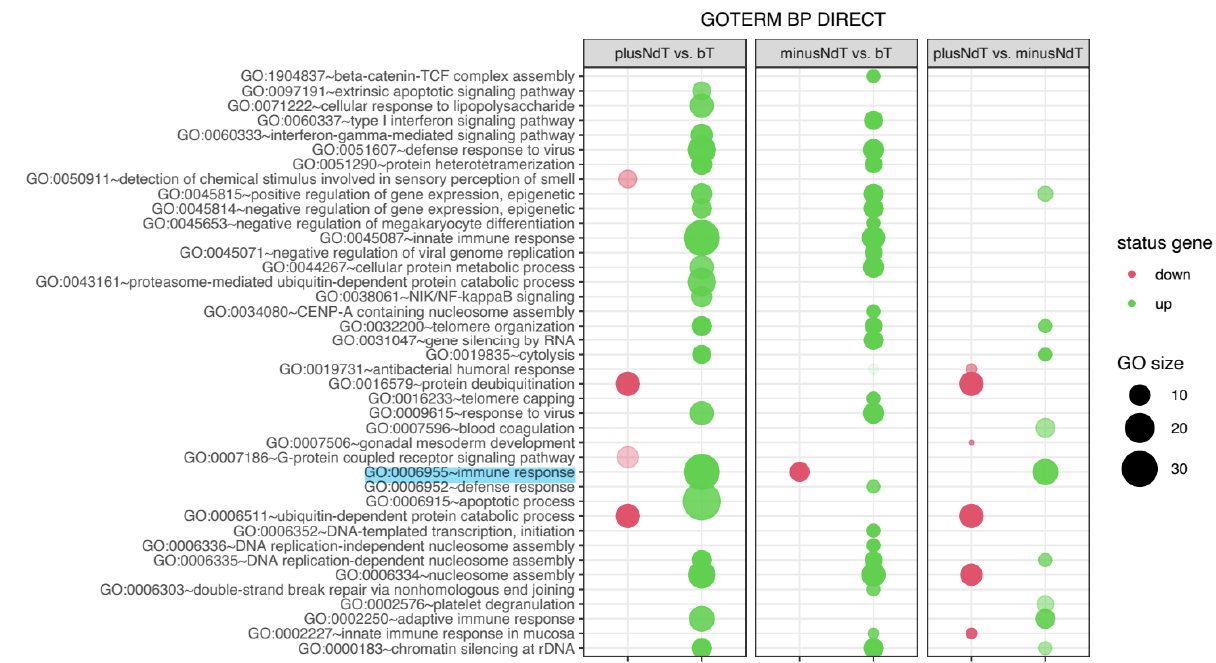
Figure 1. The volcano plot of global gene expression. Graphs ( A – C ) show comparisons with different groups. ( A ) patients with neuropathy during treatment (plusNdT) vs. the group of patients without neuropathy before treatment (minusNbT); ( B ) patients without neuropathy during treatment (minusNdT) vs. the group of patients without neuropathy before treat- ment; ( C ) patients with neuropathy during treatment vs. patients without neuropathy during treatment. Genes are repre- sented by dots. The graphs show the genes with at least two-fold change and p < 0.05. The graphs also contain the symbols of the genes with the largest change in expression.